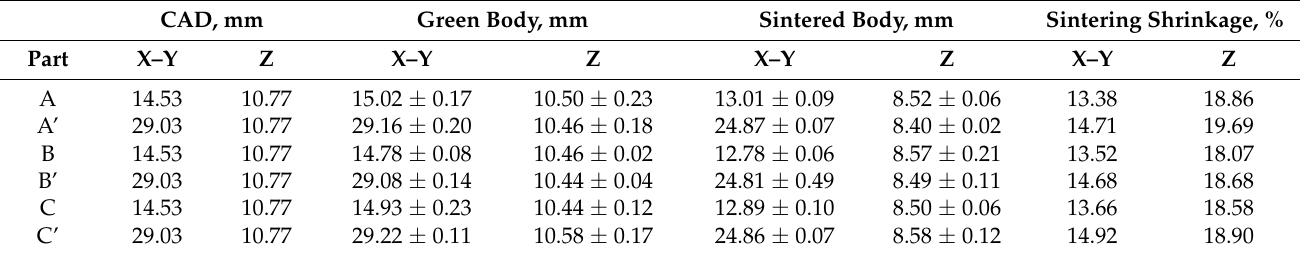
Table 2. Dimensions of the green bodies, sintered bodies, and the sintering shrinkage. CAD,